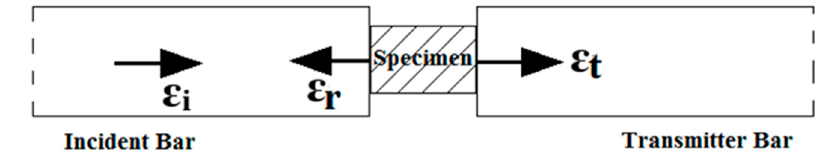
Figure 2. Schematic showing the incident, reflected and transmitted pulses.